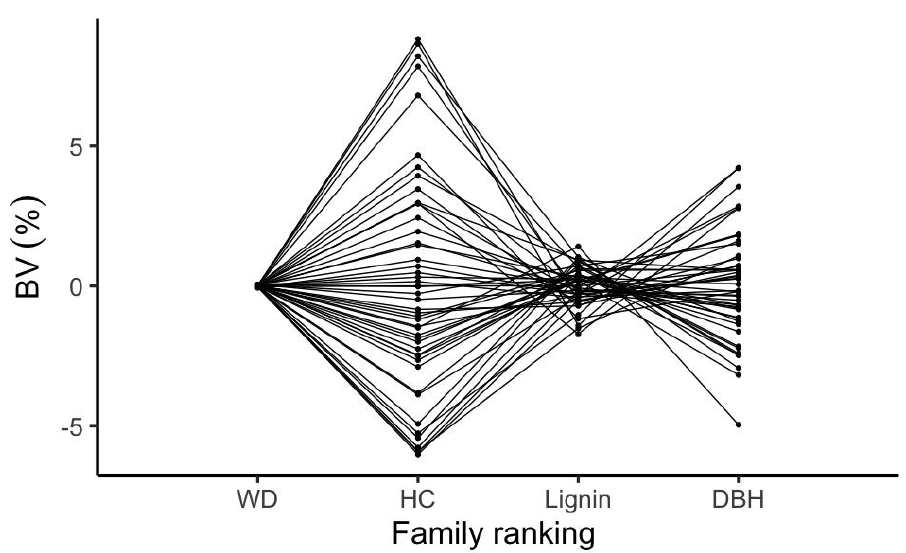
Figure 2. Family rankings for breeding value (BV) of DBH, WD, HC, and lignin in P. elliottii at age 24. Each black dot represents one family.